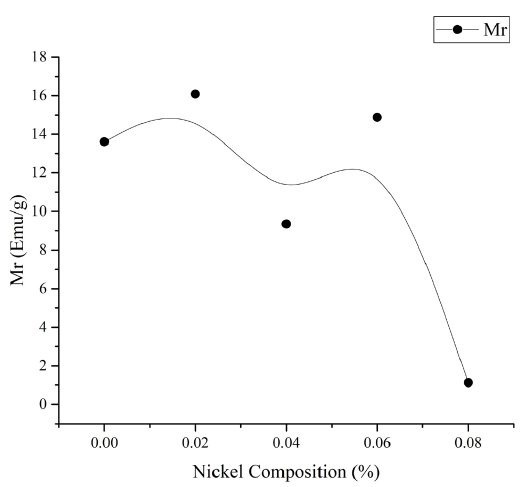
Figure 9. Comparison magnetic remanence with nickel composition Y